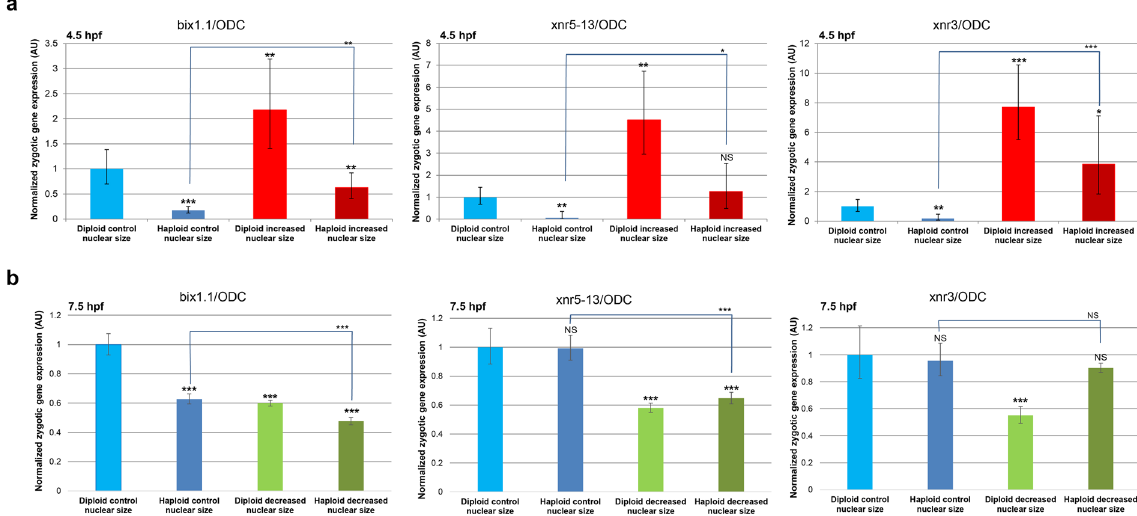
Figure 3. Quantification of zygotic transcripts by qRT-PCR in embryos with altered nuclear size and ploidy. One-cell diploid and haploid embryos were microinjected with mRNAs to increase (a) or decrease (b) nuclear size and allowed to develop to 4.5 hpf (a) or 7.5 hpf (b) . Total RNA was isolated from 30 embryos for each condition and converted to cDNA. Expression levels of three zygotic genes (xnr5-13, xnr3, and bix1.1) were determined by qRT-PCR, normalized to ODC. Gene-expression levels are plotted in arbitrary units (AU) relative to control diploid embryos. The means from two independent experiments are shown. Error bars represent SD. *** p < 0.001; ** p < 0.01; * p < 0.05; NS = not